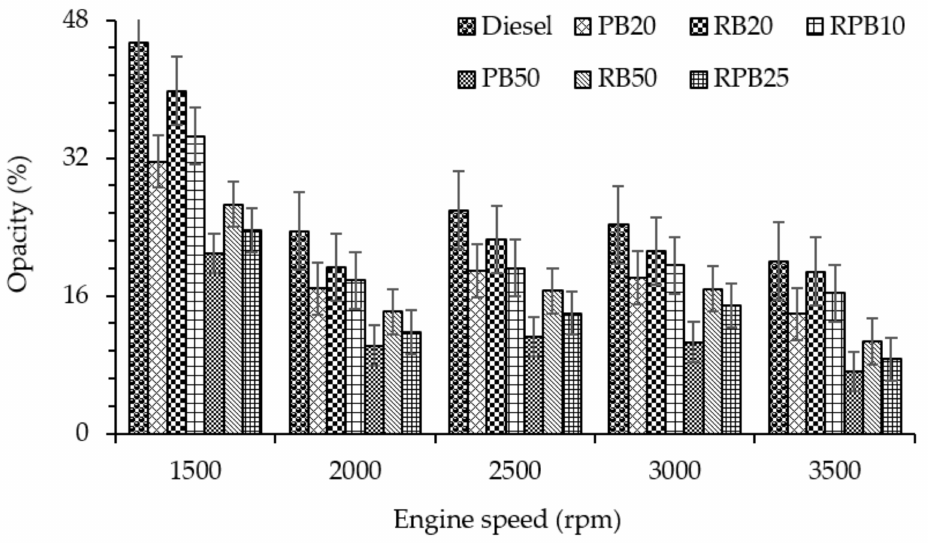
Figure 11. Variation of smoke opacity with respect to engine